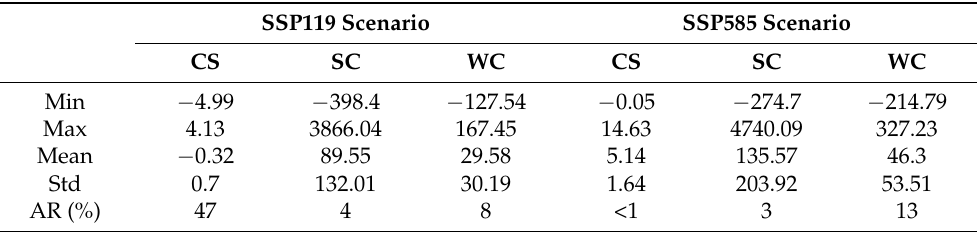
Note: Min, Max, Mean, Std, and AR indicate the minimum, maximum, mean, standard deviation, and the ratio of functional decline area of the Loess Plateau, respectively. Carbon stock function, CS (tC · ha − 1 ); soil conservation function, SC (t · ha − 1 ); water conservation function, WC